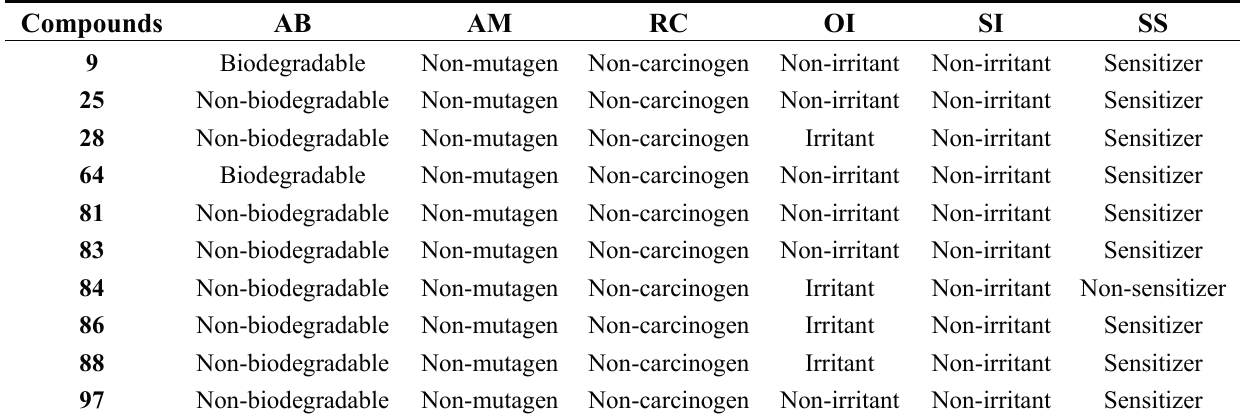
Table 8. Results of toxicity predictive test on six important